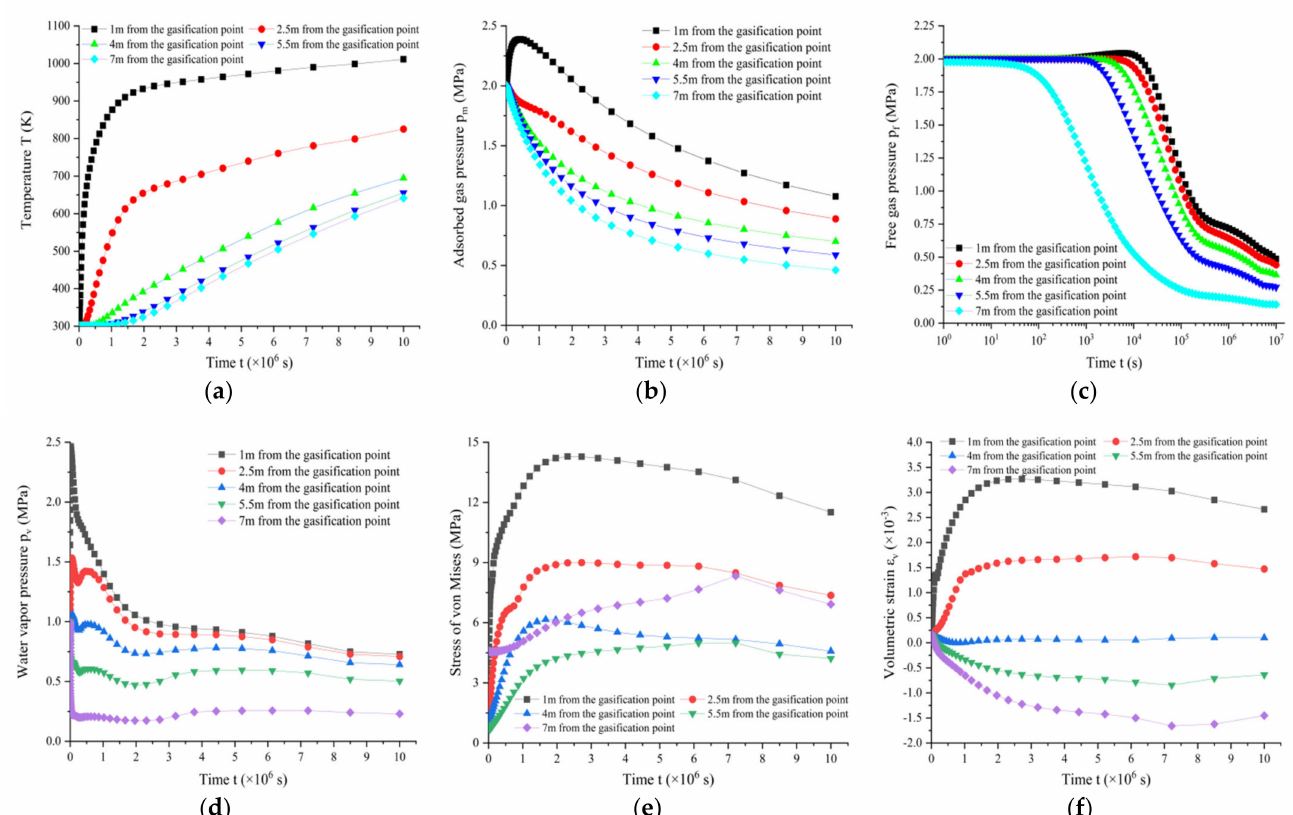
Figure 7. Temperature, barometric pressure, stress-strain and gasification point distance relationship. ( a ) temperature T ; ( b ) adsorbed gas pressure p m ; ( c ) free gas pressure p f ; ( d ) water vapor pressure p v ; ( e ) stress of von mises p v ; ( f ) volumetric strain ε v